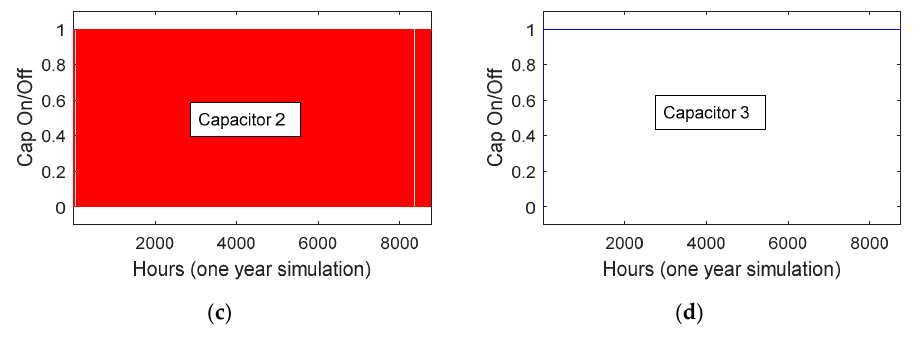
Figure 11. Smart inverter Volt-VAR control: ( a ) Regulator Tap Operation; ( b ) Capacitor bank 1 switching; ( c ) Capacitor bank 2 switching; and, ( d ) Capacitor bank 3 switching.